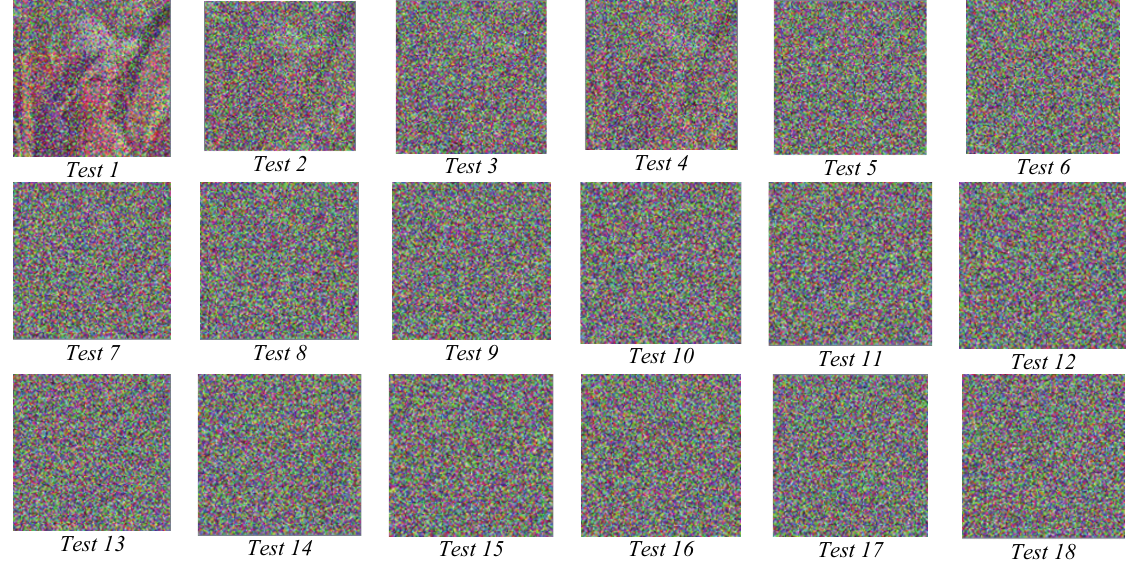
Fig. 10. Ciphering images obtained by S2CA-EX for different parameter values.